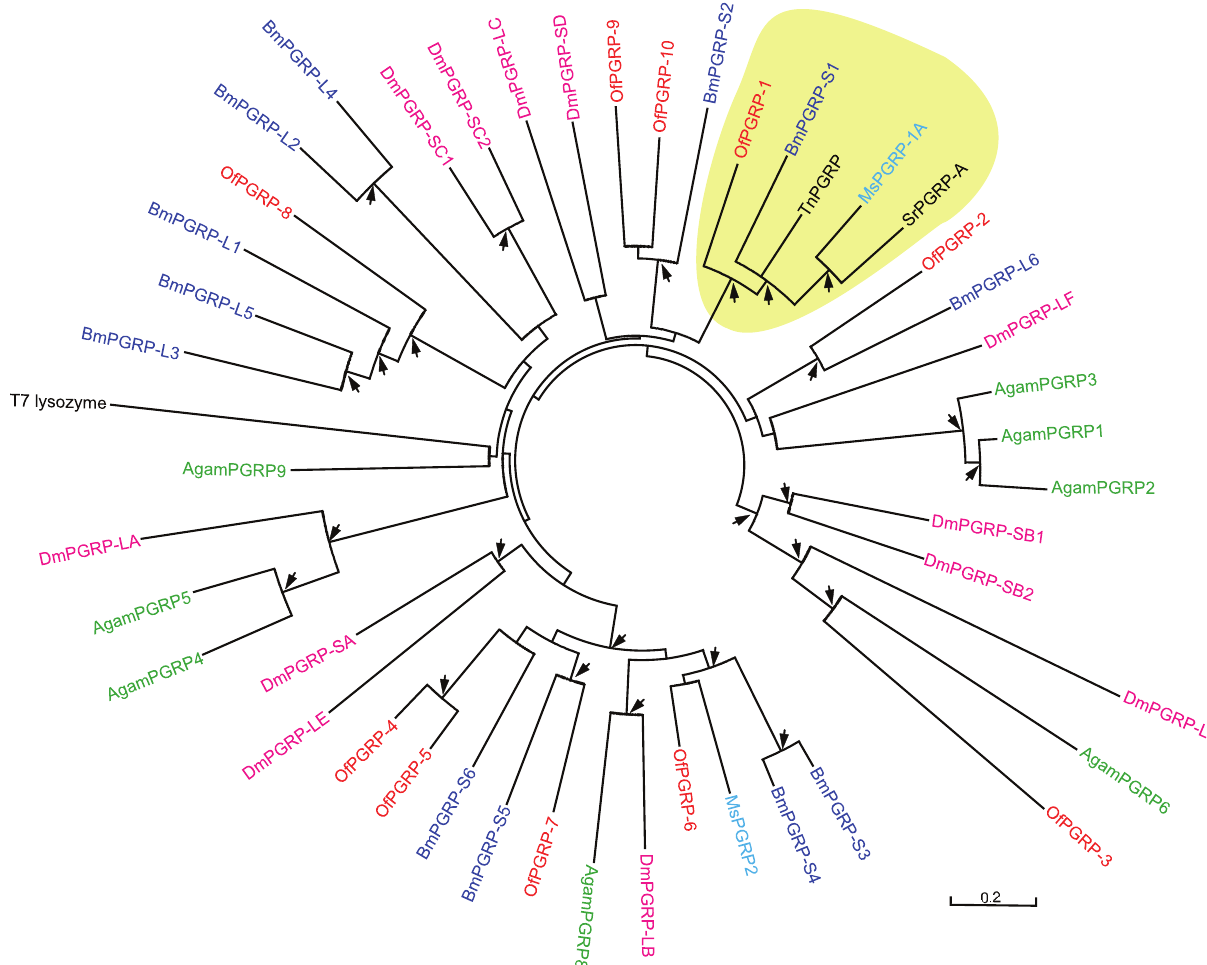
Figure 3. Phylogenetic analysis of peptidoglycan recognition proteins (PGRPs). The amino acid sequences from 10 Ostrinia (Of, red), 12 Drosophila (Dm, pink), 8 Anopheles (Ag, green), 12 Bombyx (Bm, purple), 2 Manduca (Ms, blue), one Samia ricini (Sr, black), one Trichoplusia ni (Tn, black) PGRPs, and T7 lysozyme (black) were used to build the unrooted tree. The clade that groups OfPGRP1 with other PGRPs known as recognition receptors in the PPO activation cascade (BmPGRP-S1 and MsPGRP-1A) was shaded in yellow. The arrows at nodes denote bootstrap value greater than 700 from 1000 trials.